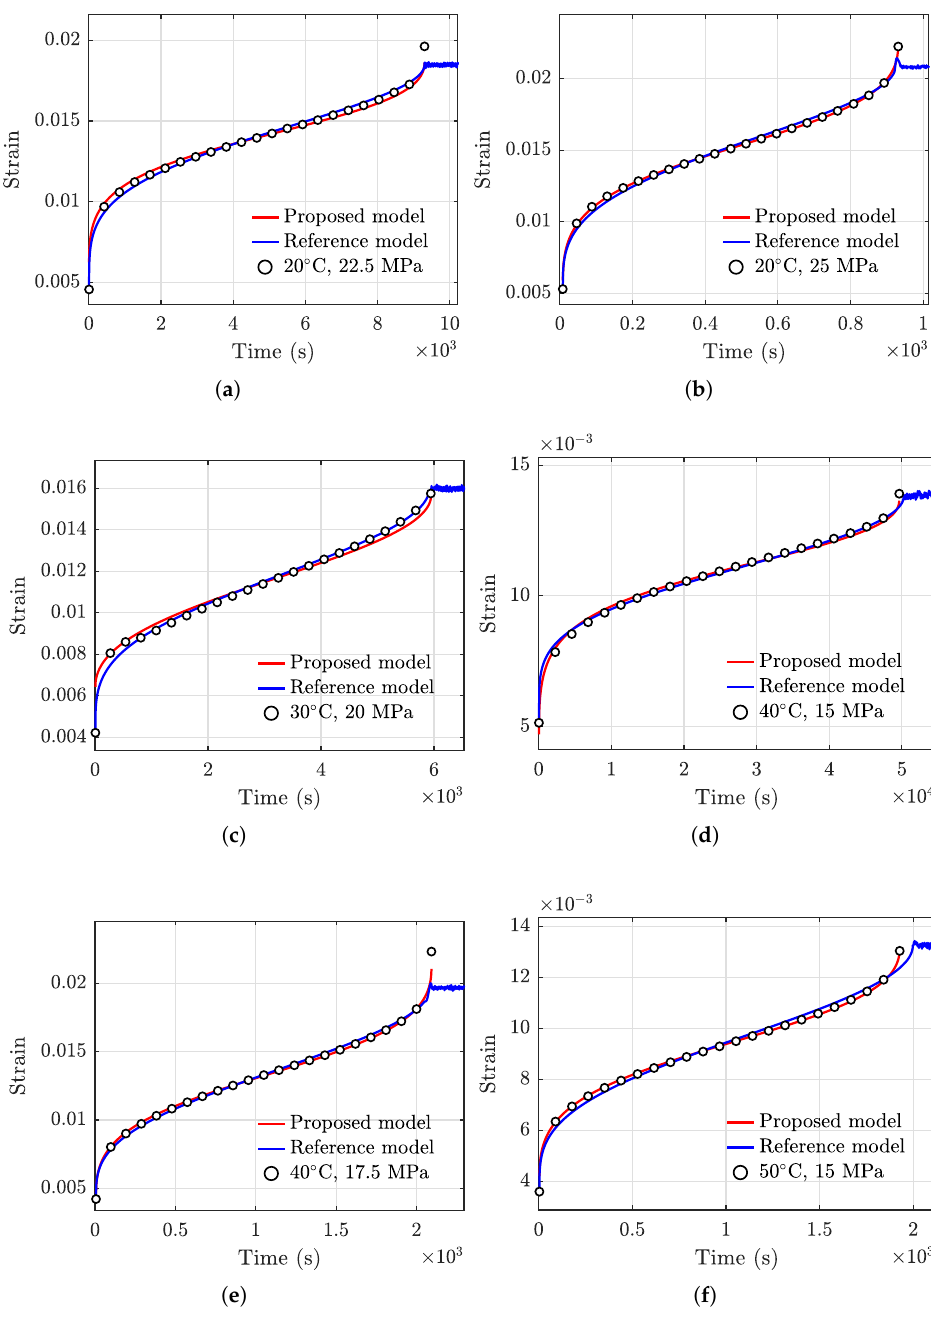
Figure 15. Comparisons of the results obtained using the proposed model and that using the reference model [51]. The discrete markers represent testing data. ( a ) 20 ◦ C, 22.5 MPa, ( b ) 20 ◦ C, 25